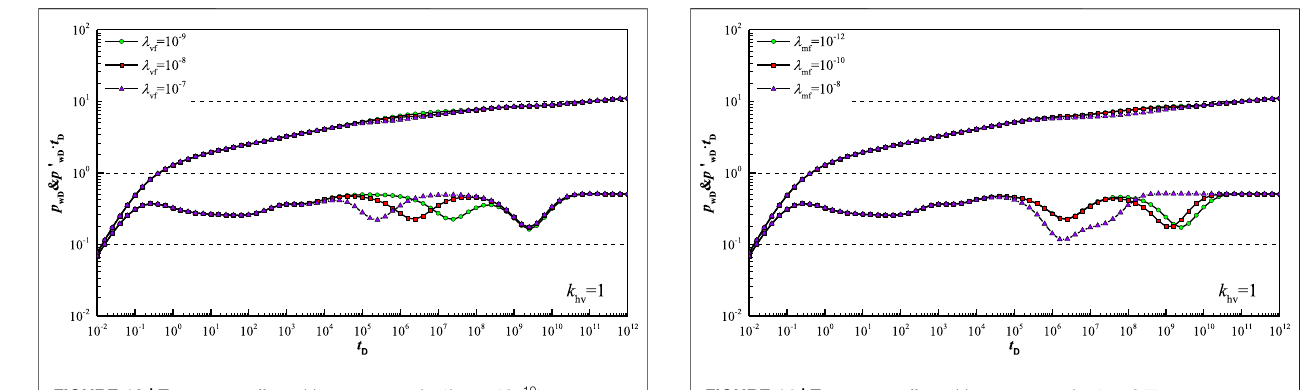
FIGURE 14 | Type curve affected by parameter λ mf ( κ (cid:2) 0 . 7 ) FIGURE 12 | Type curve affected by parameter λ Vf ( λ mV (cid:2) 10 − 10